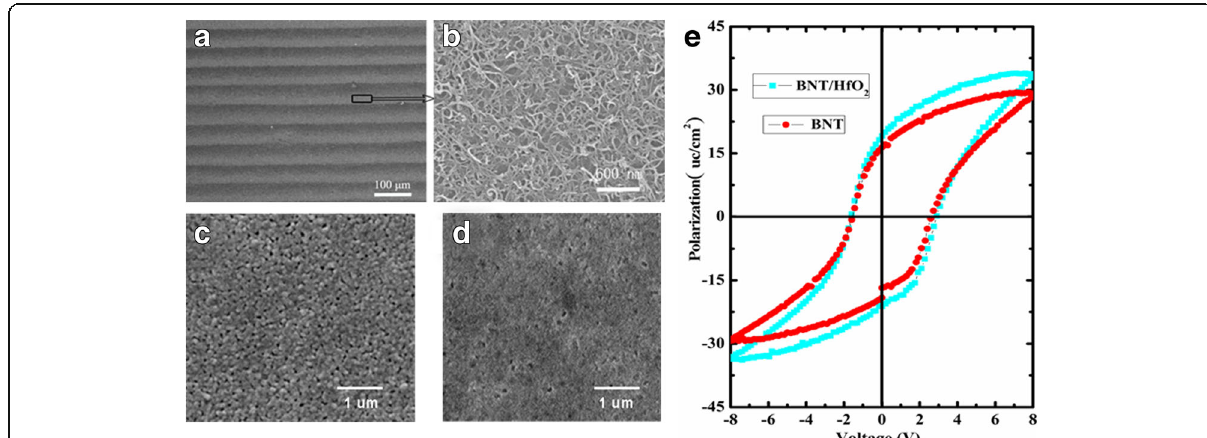
Fig. 2 a SEM micrograph of SWCNT stripe patterned in the SWCNT/BNT/HfO 2 -FeFET. b The grid structure of SWCNTs. c SEM image of the surface for BNT/HfO